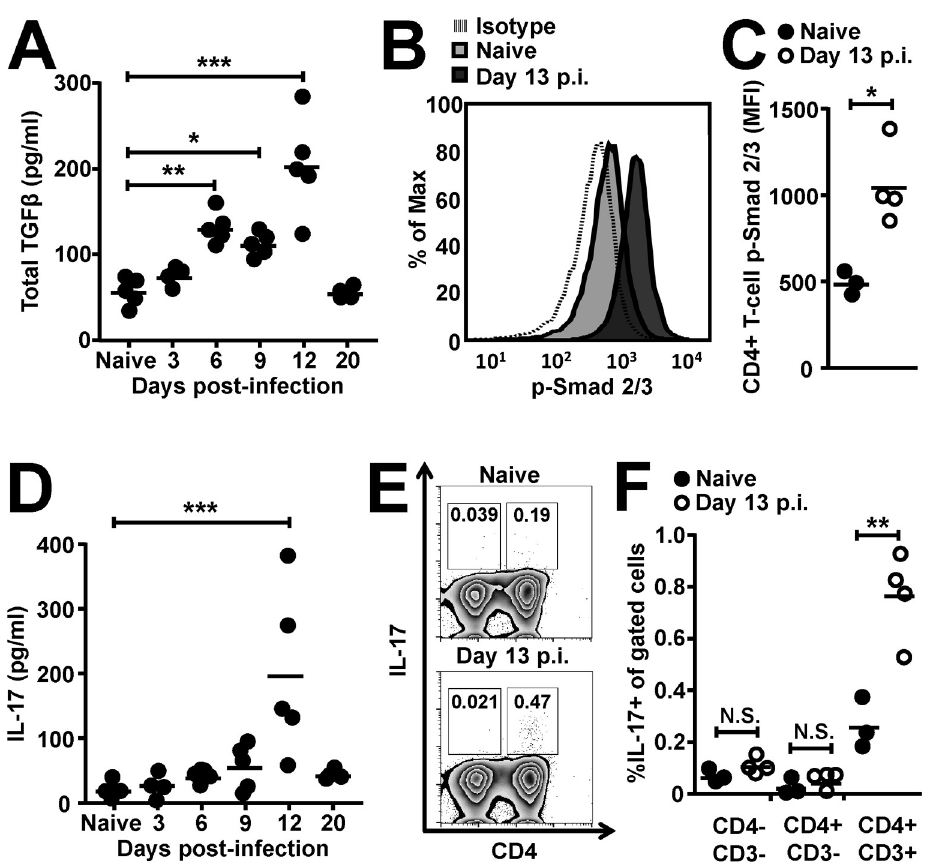
Fig 1. Infection with the small intestinal helminth T . spiralis increases TGF β signalling in CD4+ T-cells producing late Th17 cell induction. Wild-type C57BL/6 mice were infected with 300 T . spiralis larvae and examined at the indicated time points. (A) Total TGF β cytokine levels from T . spiralis antigen-stimulated mLN cells across the time-course of intestinal infection, determined via ELISA. (B) Representative flow cytometry plots and (C) mean fluorescence intensities for p-Smad 2/3 staining in small intestinal lamina propria CD4+ T-cells from uninfected and day 13 post-infected mice. (D) IL-17 cytokine levels from T . spiralis antigen-stimulated mLN cells across the time- course of intestinal infection, determined via cytometric bead array. (E) Representative flow cytometry plots of total CD45+ small intestinal lamina propria cells and (F) percentage IL-17 expression in small intestinal lamina propria CD4-CD3-, CD4+CD3- and CD4+CD3+ gated cells from uninfected and day 13 post-infected mice. Data (n = 3–5 mice per group) are from two independent experiments performed. � , P < 0.05; �� , P < 0.01; ��� , P < 0.005; N.S., not significant via Dunnett’s multiple comparison following ANOVA (A) and (D) or student’s t-test (C) and (F) for the indicated comparisons between groups.